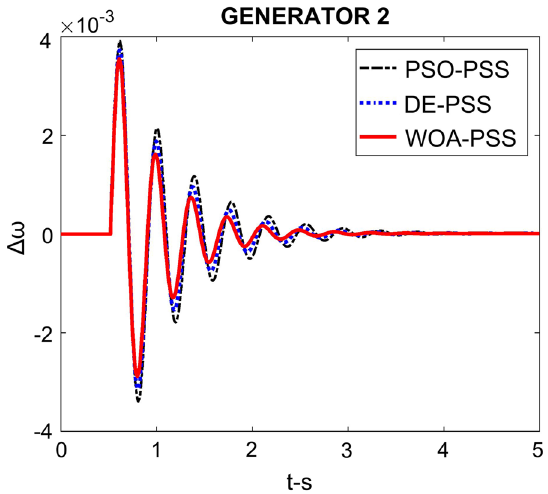
Fig. 11 Speed deviation of G2 for 10% step change at turbine